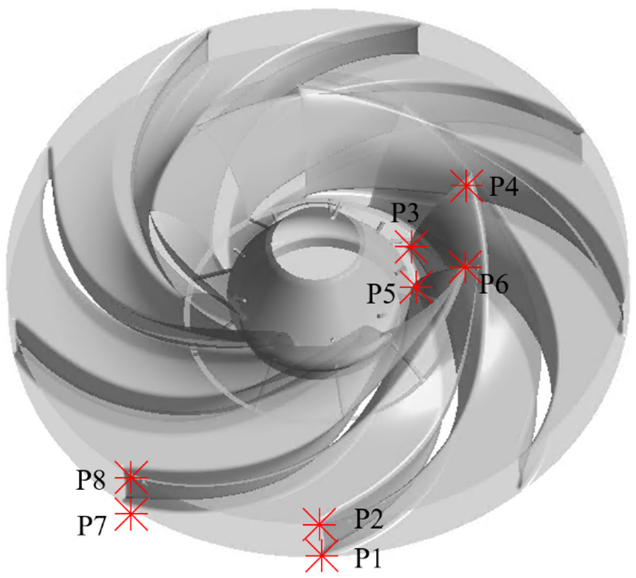
Figure 2. Pressure pulsation monitoring points and dynamic stress monitoring points.